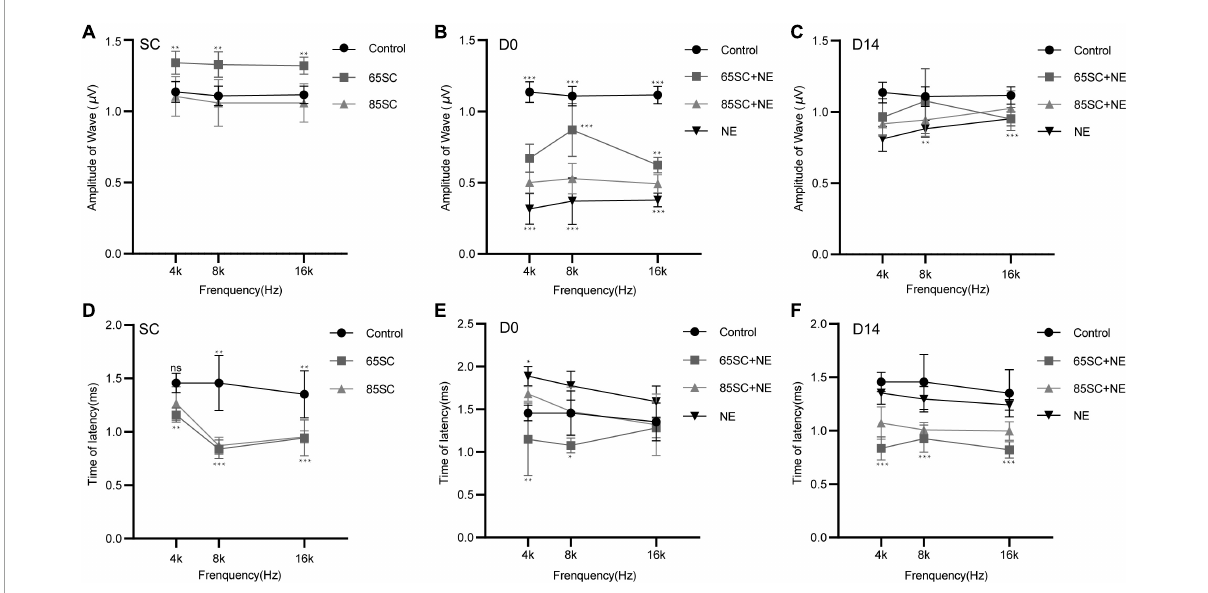
FIGURE3 Amplitudes and Latencies of wave I at each time point after sound conditioning or noise exposure. (A) The amplitude of wave I in the 65SC group significantly increased than that in the control group at all frequencies after sound conditioning ( p < 0.01); the amplitude of wave I did not differ between the 85SC group and the control group ( p > 0.05). (B) ABR I wave amplitudes decreased significantly in all groups at D0. The amplitude of wave I in the NE group decreased obviously ( p < 0.001). Comparing with 65SC+NE group, the amplitude of wave I in the 85SC+NE group was decreased at 8 kHz ( p < 0.001) and 16 kHz ( p < 0.01). (C) At D14, wave I recovered at all frequencies for all groups, with the 65SC+NE and 85SC+NE groups recovering to pre-exposure levels, while the NE group had not fully recovered at 8 kHz ( p < 0.01) and 16 kHz ( p < 0.001). (D) The latency of wave I in the 65SC group was significantly shorter than that of the control group at all frequencies after sound conditioning especially at 8 and 16 kHz ( p < 0.001); and latency in the 85SC group was also shorter than that in the control group, except at 4 kHz ( p < 0.01); the latency of wave I did not differ between the 65SC group and the 85SC group ( p > 0.05). (E) The latency of wave I did not differ between the SC+NE groups and the control group at D0 ( p > 0.05); and in the NE group the latency of wave I was prolonged especially at 4 kHz ( p < 0.05). Comparing with 85SC+NE group, the latency of wave I in the 65SC+NE group was shorter at 4 kHz ( p < 0.01) and 8 kHz ( p < 0.05). (F) The latency of wave I did not differ between the NE group and the control group at D14 ( p > 0.05); the latency of wave I in the SC+NE groups was still significantly shorter than that of the control group ( p < 0.001). * p < 0.05, ** p < 0.01, *** p < 0.001.